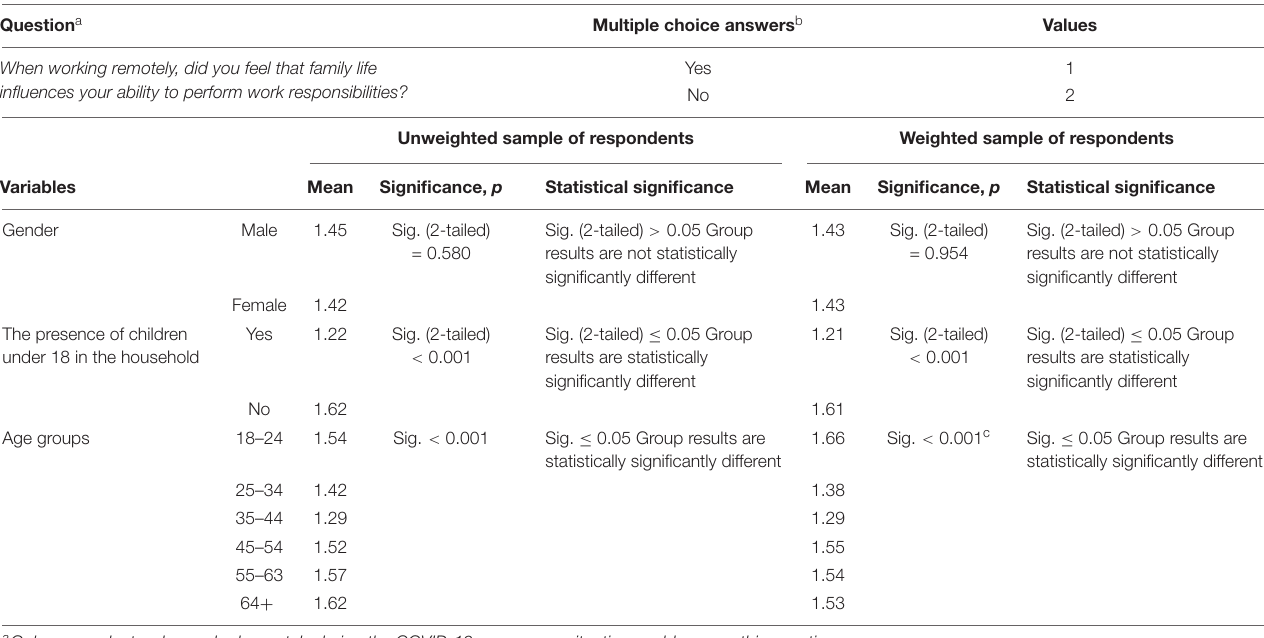
TABLE 2 | Analysis of respondents’ answers to the question “When working remotely, did you feel that family life affects your ability to perform work responsibilities?” ( n = 522). Question a Multiple choice answers b